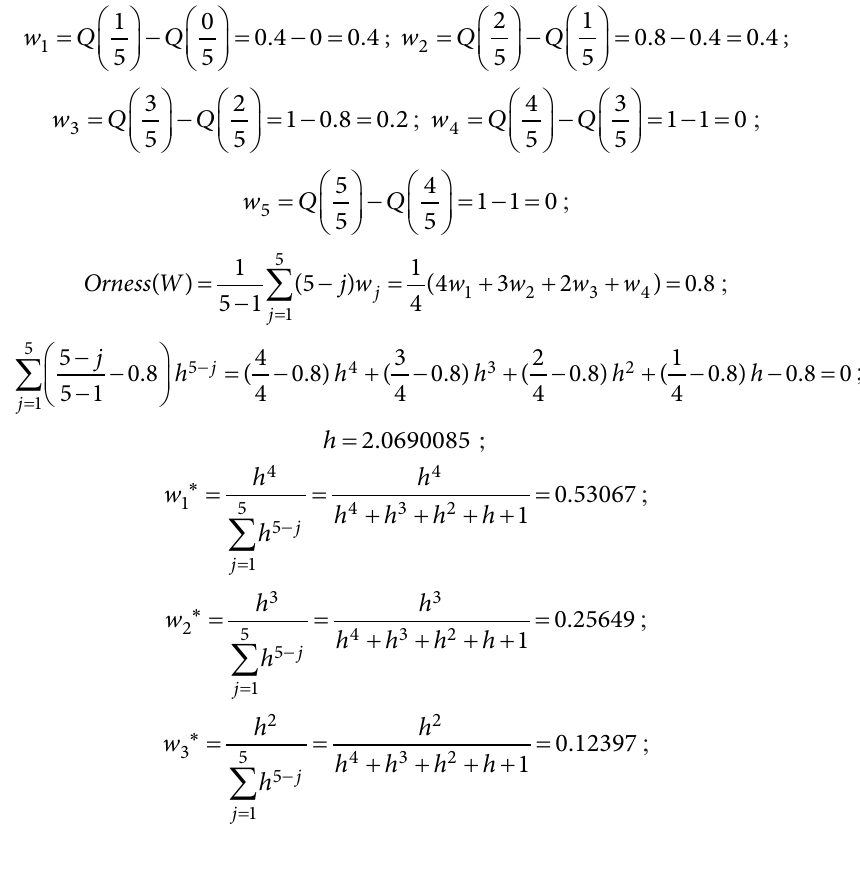
Convenience for carry-on quality